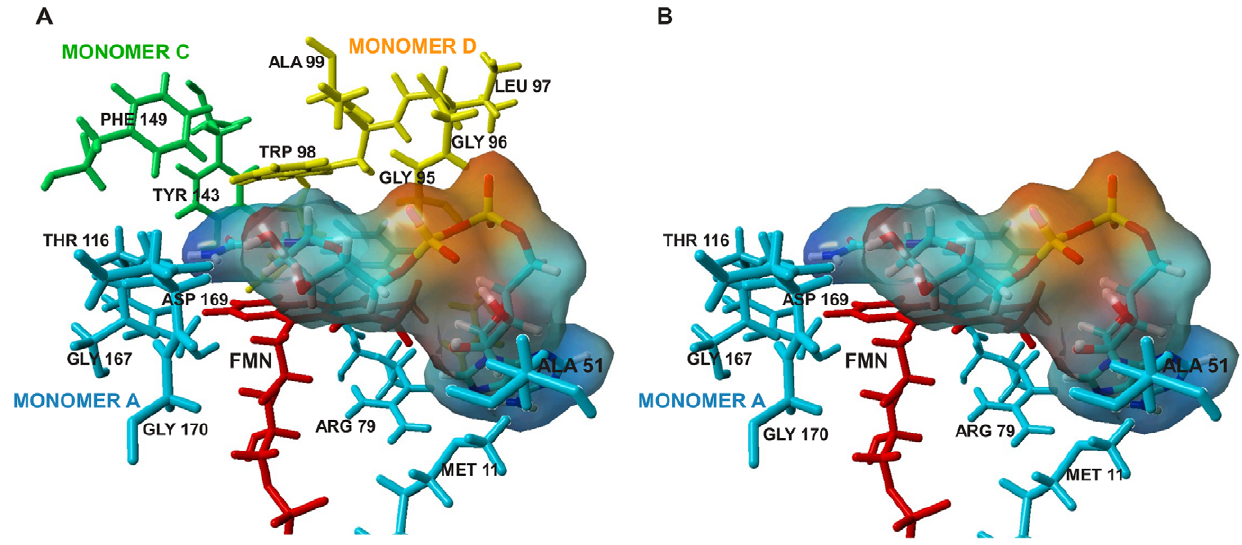
Figure 7. NADH contacts. View of the active site residues in direct contact with bound NADH in the optimized docked position. Oxidized FMN is depicted as a skeletal model in red; NADH is depicted as a skeletal model in atomic colors with translucent electrostatic potential surface shaded from red (negative charge) to blue (positive charge). Residues contacting NADH from monomer A are in light blue, from monomer C in green and from monomer D in yellow. A, tetramer. B, dimer.